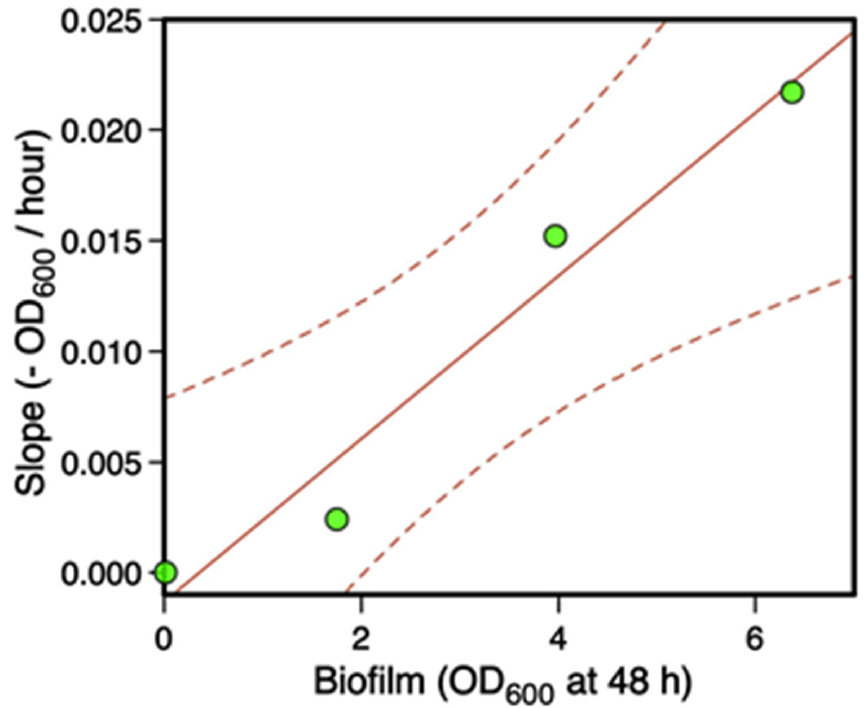
Figure 4. Relation between the slope (OD 600 /h) of the planktonic population decrease and the biomass of 48-h-aged biofilms. Data were obtained from strains Bt407, ATCC10987, ATCC14579 and AH829. The linear regression (slope vs. biofilm) was significant ( p < 0.05, r = 0.98).